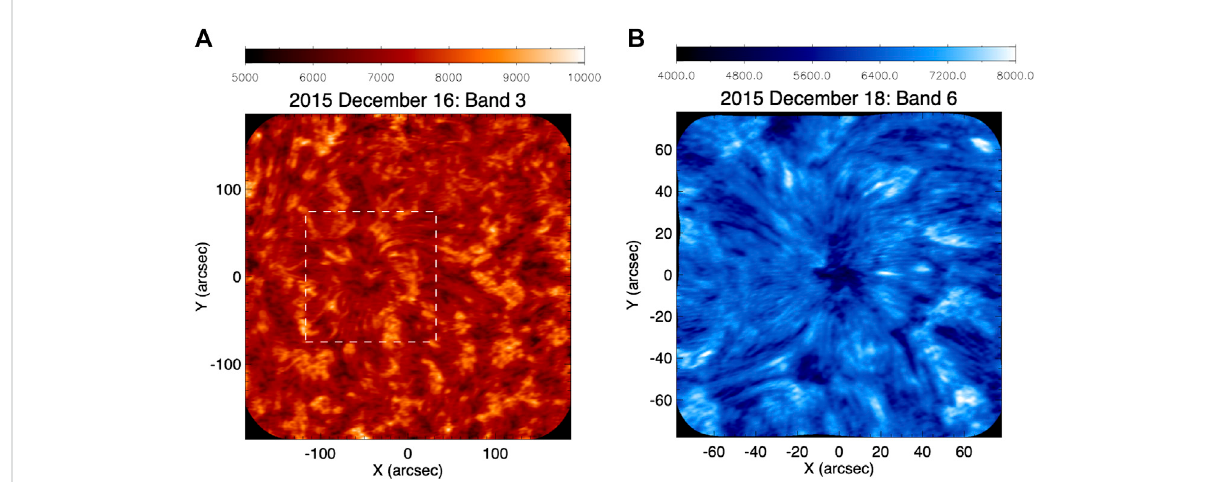
FIGURE 2 Examples of large-format mosaics from ALMA science veri fi cation data. (A) : a 149-pt mosaic in Band 3 (3 mm) of a sunspot-containing active region. (B) : a 149-pt mosaic in Band 6 (1.25 mm) of the same sunspot 2 days later. The equivalent fi eld of view of the Band 6 image is shown on the Band 3 as a dashed-line box. Note the difference in brightness temperature scale. See also Shimojo et al.